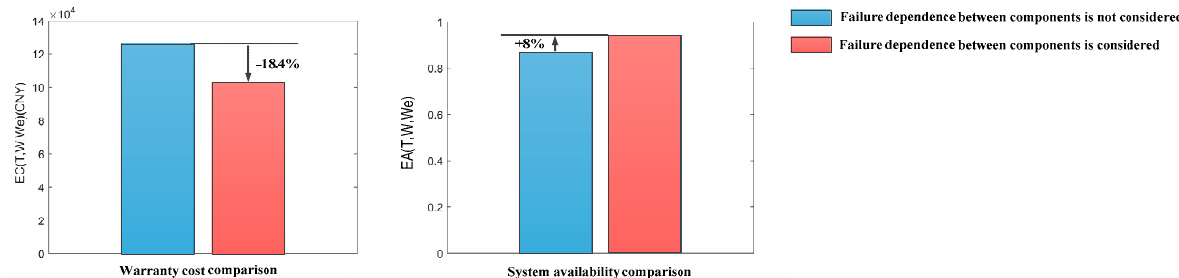
Figure 13. Comparison between considering and not considering failure dependence.